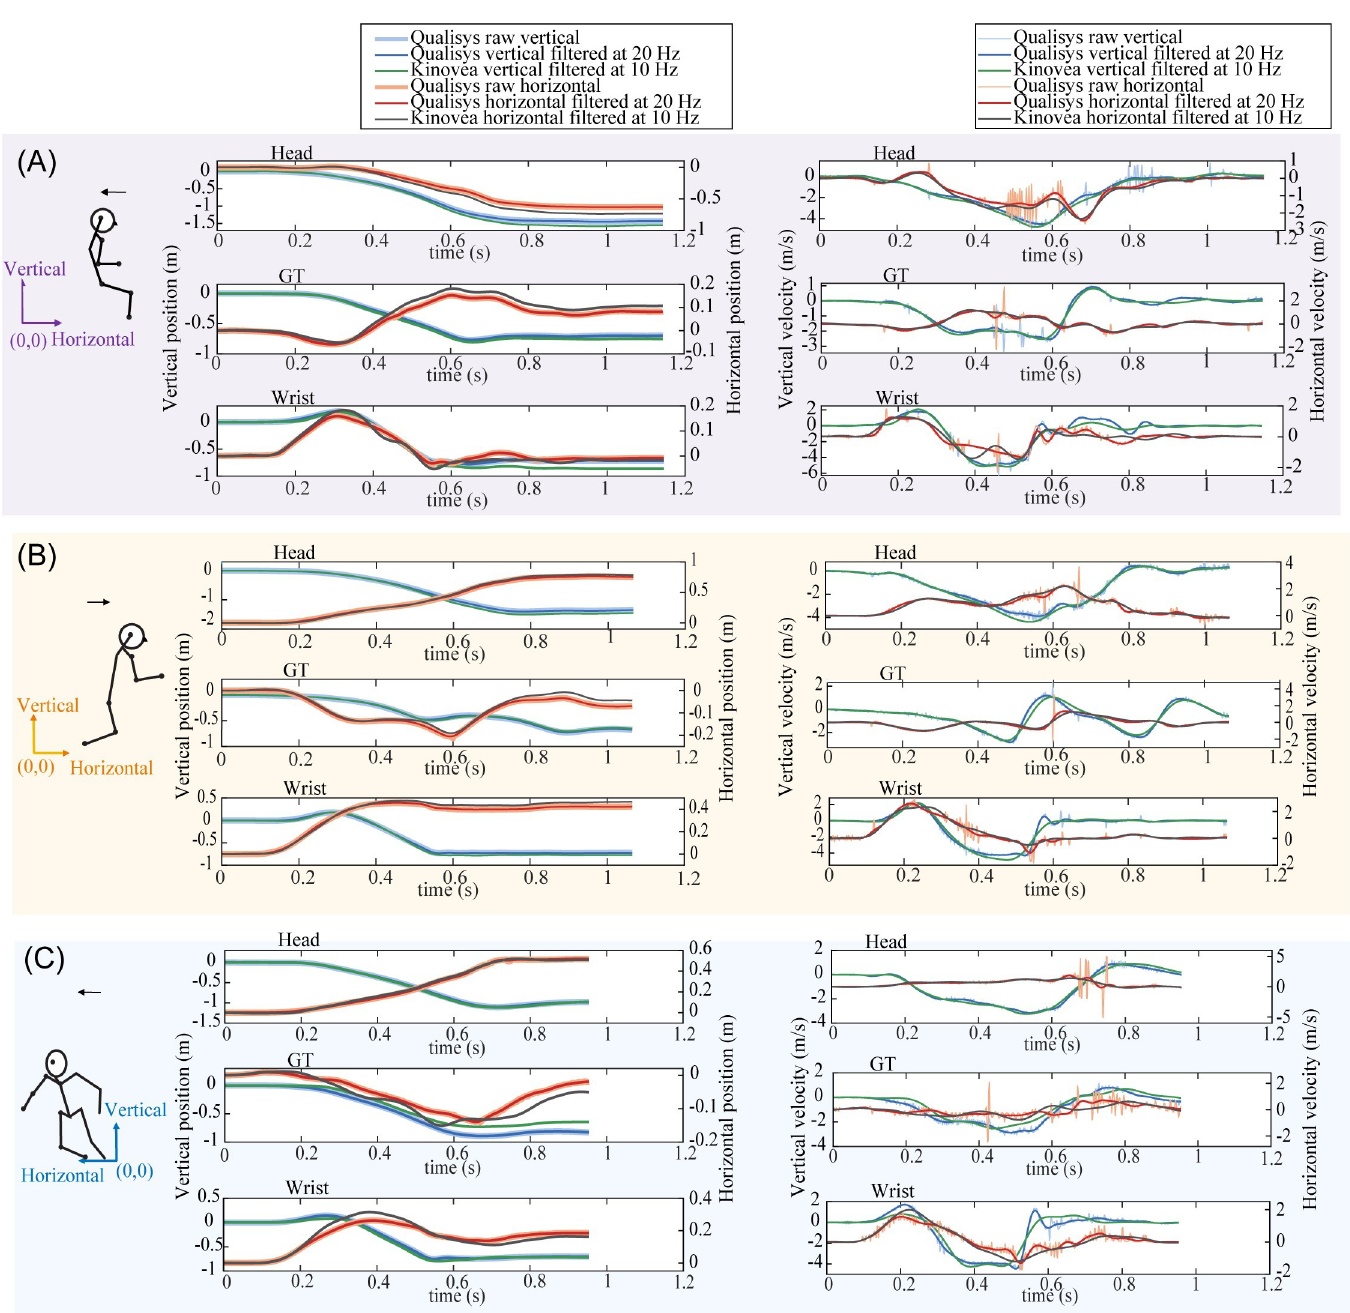
Fig 2. Time-varying linear positions and velocities measured from 3D motion capture (Qualisys) and Kinovea. The images show perturbation-based falls experienced by a 32 year old woman in the (A) backward fall direction, (B) forward fall direction, and (C) sideways fall direction. All traces are between onset of platform movement (time = 0) and end of fall (cessation of movement). Raw unfiltered data show considerable non-physiological noise. A 20 Hz low pass filter of Qualisys position data retained 96% of the energy content for 96.7% of the vertical velocity traces.